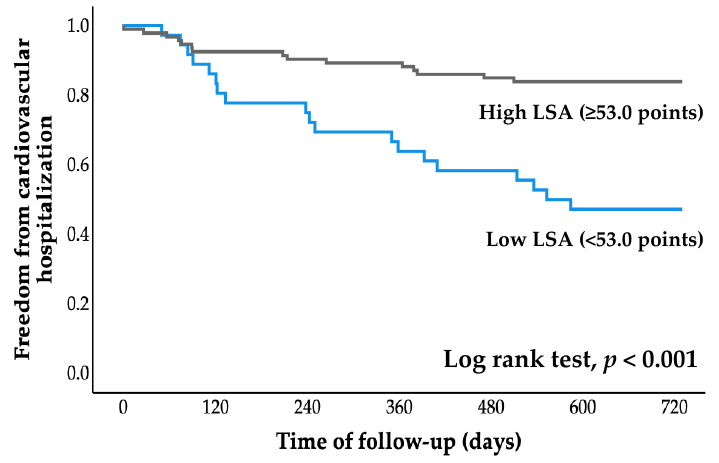
Figure 2. Kaplan–Meier curve for cardiovascular hospitalization. LSA, life-space assessment. Figure 3. High LSA ( ≥ 53.0 points)